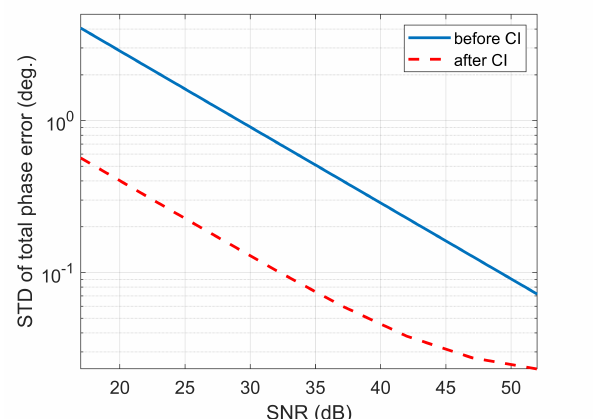
Figure 11. The comparison of STD of total phase errors versus the SNR before coherent integration and after coherent integration. The coherent integrating number L = 51.